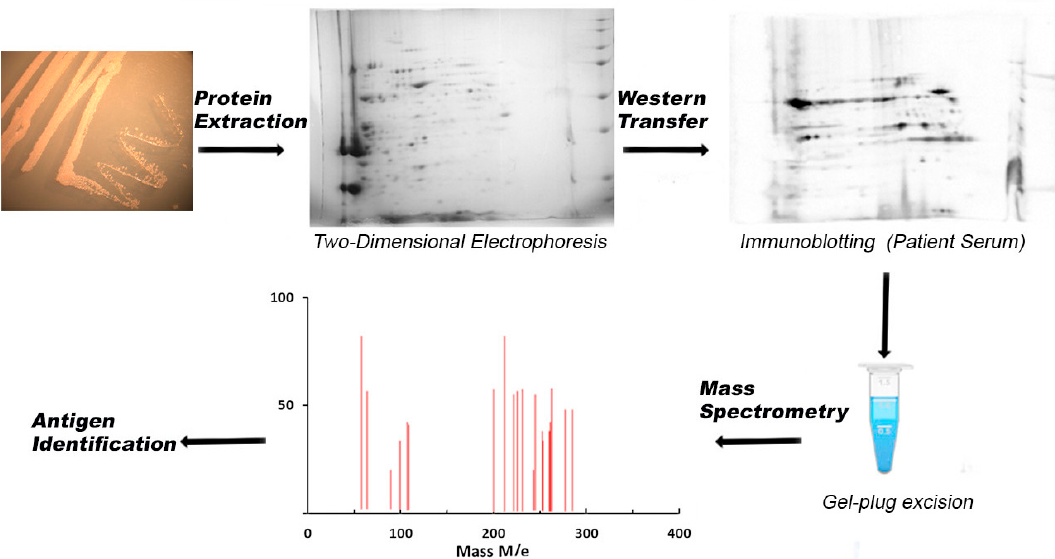
Figure 1. Schematic flowchart of the steps involved in the identification of a pathogen immunoproteome, illustrating bacterial protein extraction, protein separation by 2D gels, Western blotting using patient serum samples, and protein identification by mass spectrometry.